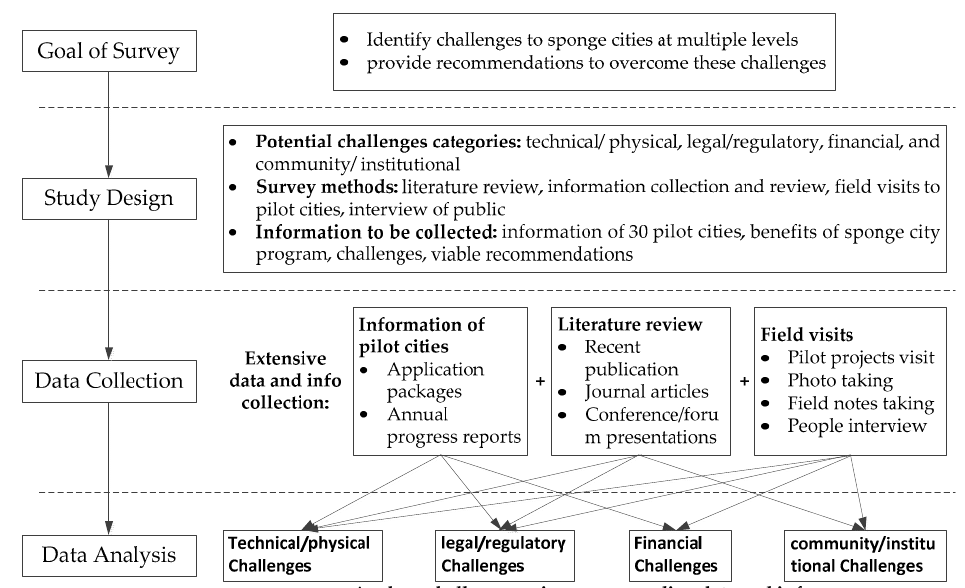
Figure 4. Flow chart of the survey work.